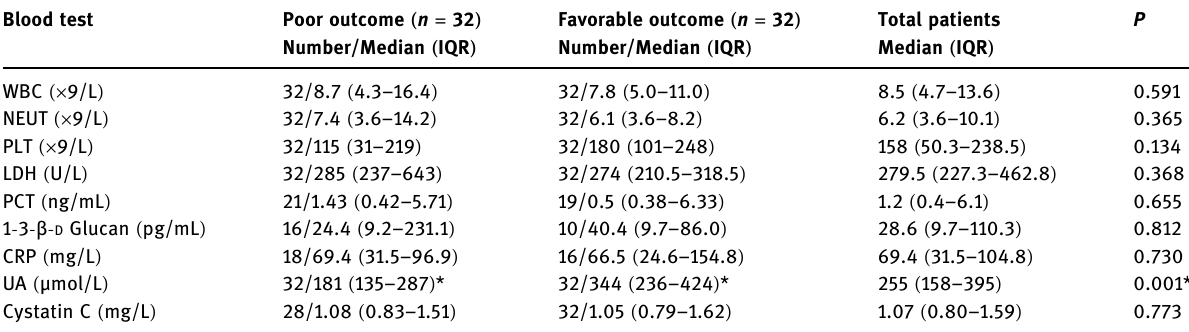
Table 4: Blood test results of patients with candidemia based on outcome Blood